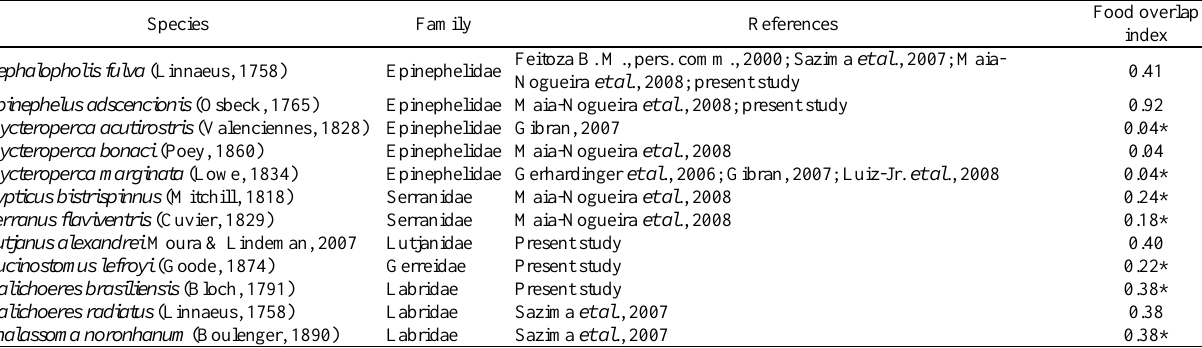
Table 1. List of the follower fishes of Myrichthys ocellatus and food overlap index between them. Data are from present study and also from literature. *index calculated with values from the diet of species from the Species Family